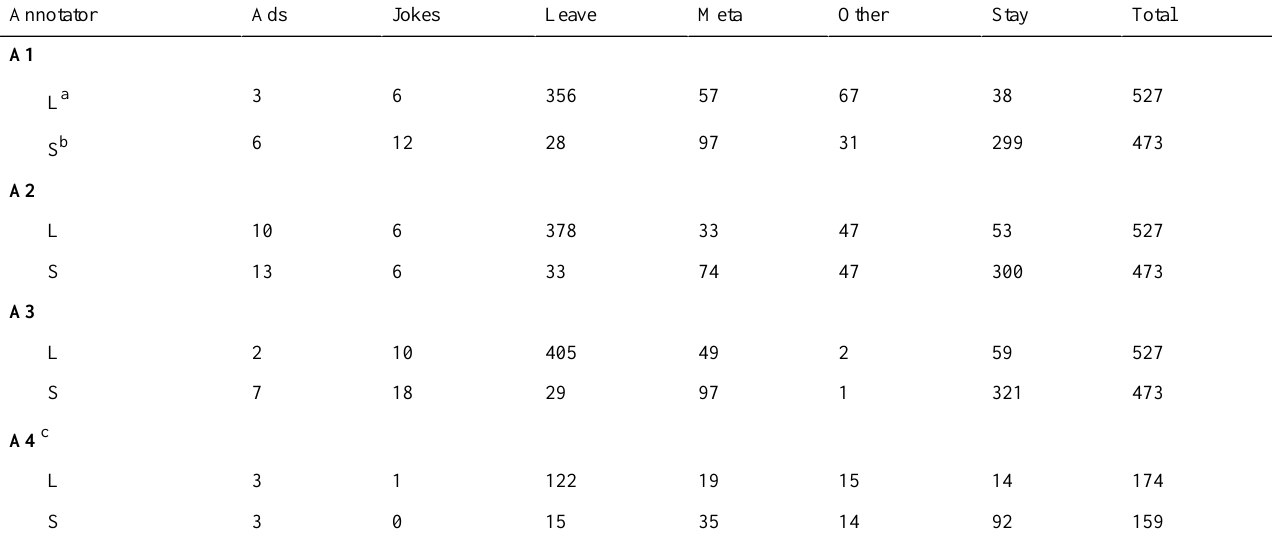
Table 1. Summary of labels from all four annotators, A1 through A4, compared with the gold standard. Each cell indicates the number of tweets an annotator gave a label